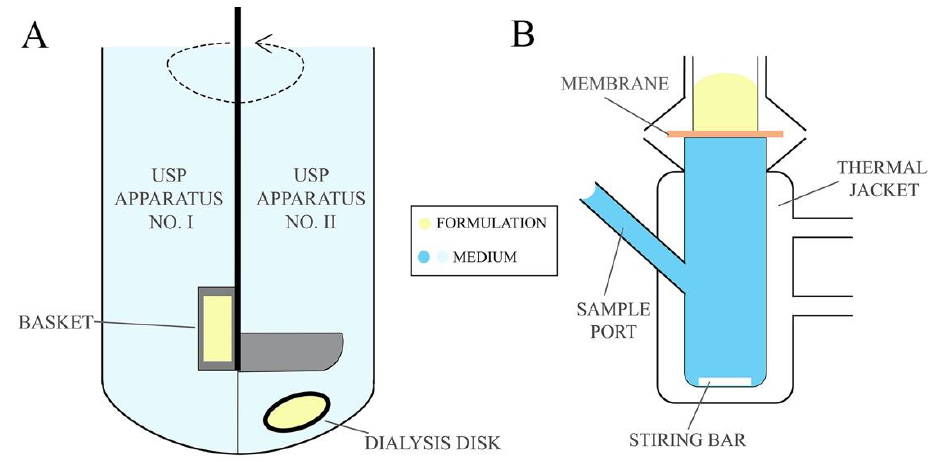
Figure 5. ( A ) USP dissolution apparatus and ( B ) Franz Cells unit.